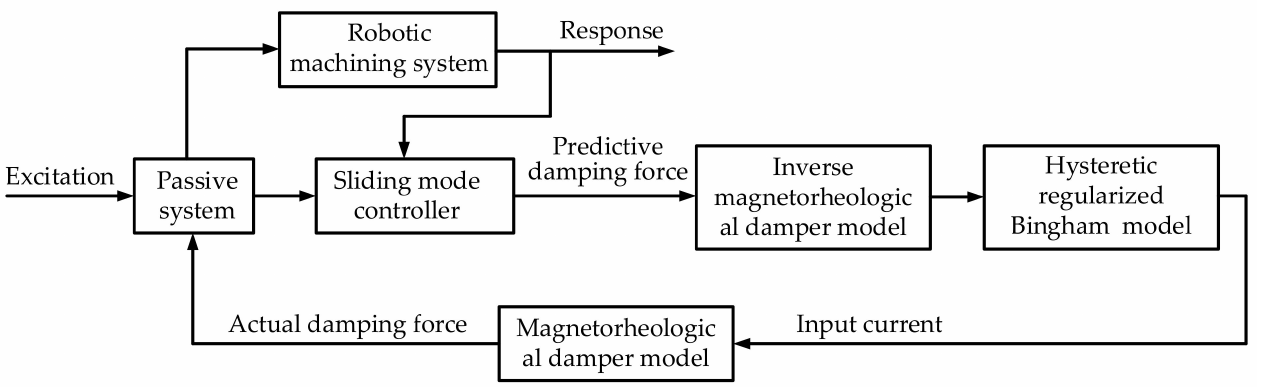
Figure 17. The scheme of the control